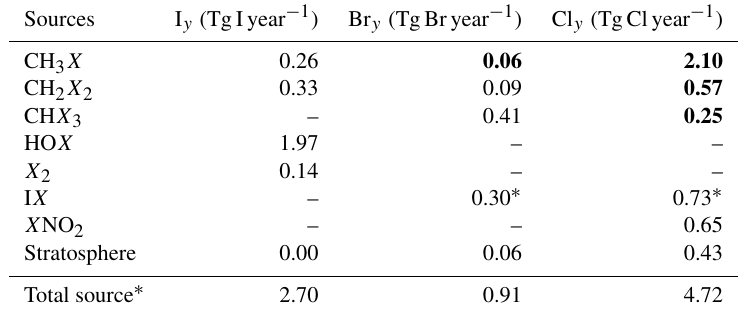
Table 2. Global sources of reactive tropospheric inorganic halogens. Sources with fixed concentration in the model for Cl y (CH 3 Cl, CH 3 Cl 2 , CHCl 3 ) and Br y (CHBr 3 ) are shown in terms of chemical release (e.g. + Cl, + OH, + hν ) and are in bold. Inclusion of chlorine and bromine organic species has been reported before in GEOS-Chem (Eastham et al., 2014; Parrella et al., 2012; Schmidt et al., 2016). X 2 (I 2 ) and HO X (HOI) are the inorganic ocean source from Carpenter et al. (2013); X NO 2 is the source from the uptake of N 2 O 5 on sea salt (ClNO 2 ). Sources I y (TgIyear − 1 ) Br y (TgBryear − 1 ) Cl y (TgClyear − 1 ) CH 3 X 0.26 0.06 2.10 CH 2 X 2 0.33 0.09 0.57 CH X 3 – 0.41 0.25 HO X 1.97 – – X 2 0.14 – – I X – 0.30 ∗ 0.73 ∗ X NO 2 – – 0.65 Stratosphere 0.00 0.06 0.43 Total source ∗ 2.70 0.91